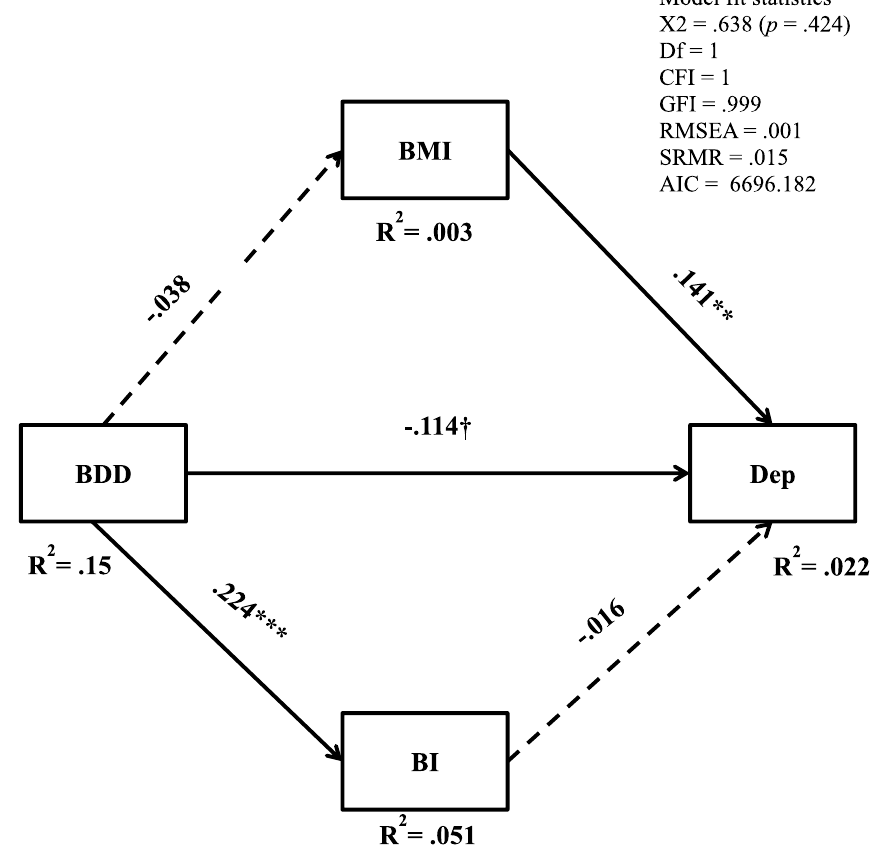
Fig. 2 The standardized coefficient (beta) for the association between BDD and depression controlling BMI and BI is in parentheses. The dashed arrow indicates non-significant effect(s), and the solid arrow indicates significant effect(s). R. 2 represents the total variation in a dependent variable explained by the combined independent variables. The model fit statistics summary is presented. * p < .05, ** p < .005, *** p <